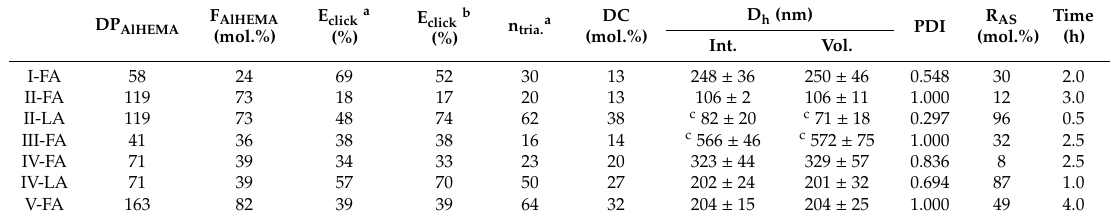
Table 2. Data for obtained conjugates and release e ff ect of active substances.